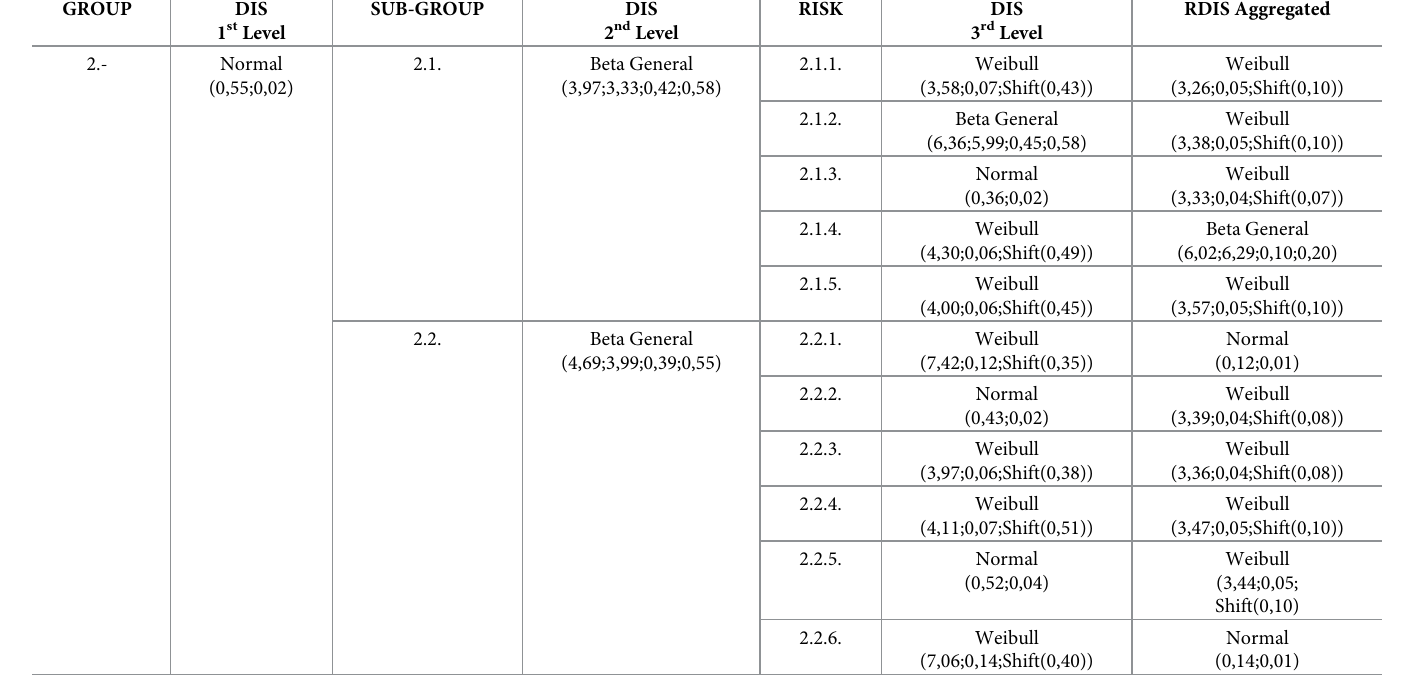
Table 5. RDIS hierarchy aggregation: Technological